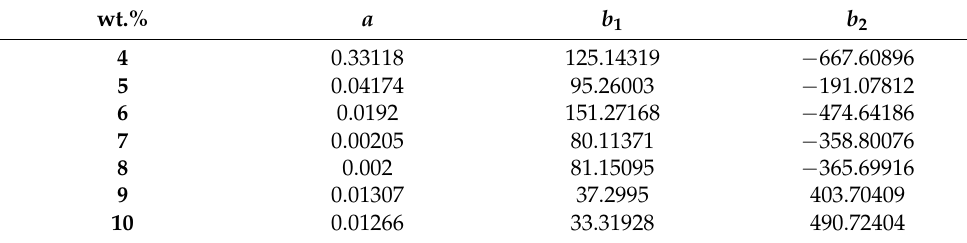
Table 3. Correlation coefficient of exponential function for different MWCNT doping ratios. wt.% a b